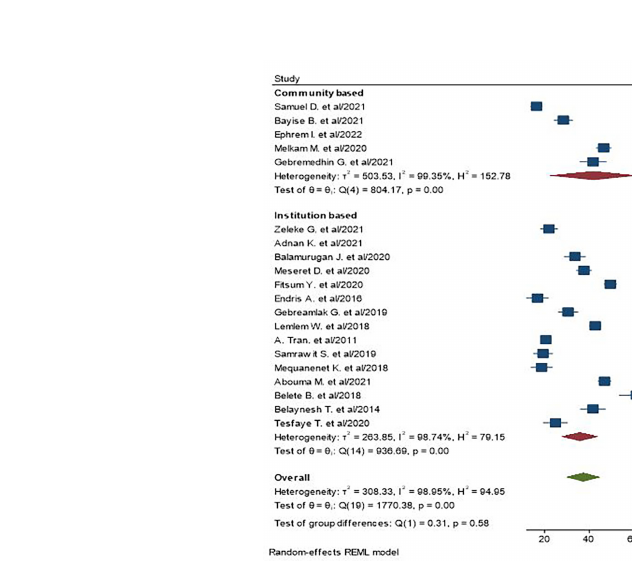
FIGURE 4 The pooled prevalence of central obesity among adult populations based on setting in